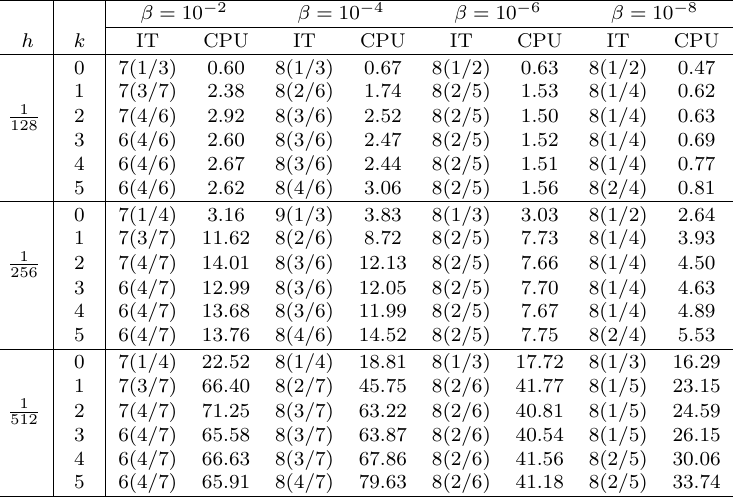
Table 1. Problem 1: Performance results for FGMRES, A preconditioned by C in (4.1)